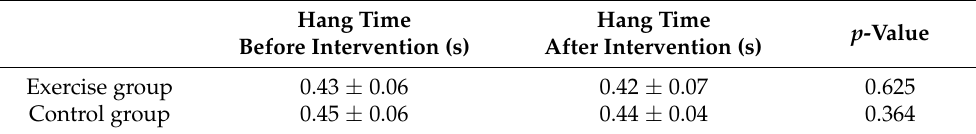
Table 3. Hang time in each group before and after intervention. Hang Time Hang Time p -Value Before Intervention (s) After Intervention (s) Exercise group 0.43 ± 0.06 0.42 ± 0.07 0.625 Control group 0.45 ± 0.06 0.44 ± 0.04